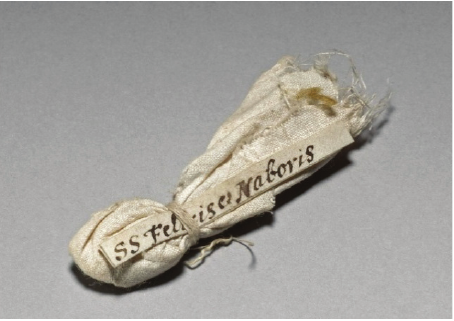
Figure 3: Relic tag with accompanying relic textile bundle (BM No.1902,0625.1.ab).